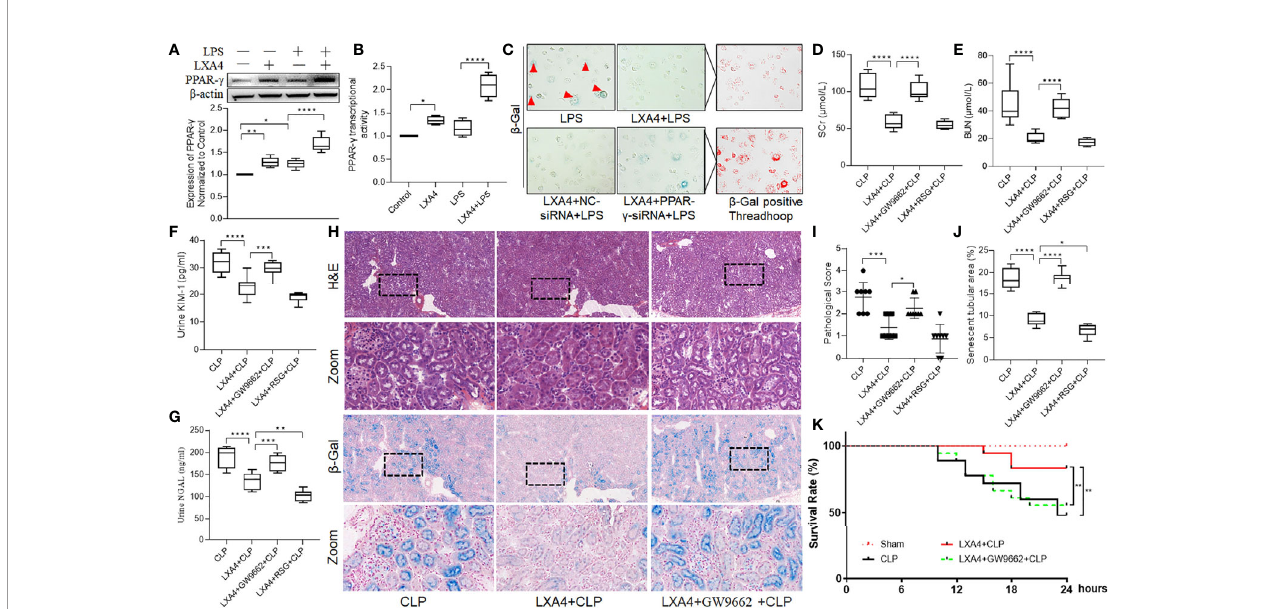
FIGURE 5 | LXA4 attenuates AKI and increased rat survival rate in a PPAR- g -dependent manner. NRK52E cells were treated with 1 m g/ml LPS for 24h with or without 10 nM LXA4 pretreatment for 12h, and PPAR- g -siRNA transfection for 48h. Male Sprague-Dawley rats were treated with or without LXA4 (100 µg/kg, i.p. ) for 30-min, or GW9662 (1 mg/kg, i.v. ) or RSG (10 mg/kg, i.v. ) for 20min prior CLP and were sacri fi ced at the time point of 18-h after surgery. Renal function alternation, renal pathological injury and senescence in the neighbored section were detected. (A) expression of PPAR- g among the four groups. (B) PPAR- g transcriptional activity among the four groups. (C) Representative images of NRK52E cell senescence among the four groups. (D – G) levels of SCr, BUN, urinary KIM-1 and NGAL among the four groups. (H) Representative images of renal damage and cellular senescence in the neighbored kidney section among the four groups (H&E and b -Gal staining; scale bar 100 m m). (I, J) Kidney histopathology scores and senescent tubular area among the four groups. (K) Survival rate after LXA4 treatment. The survival rate was observed for 24-h after the CLP operation, n=18. (A – G) Data are presented as mean ± SE (n = 8). * p < 0.05; ** p < 0.005; *** p < 0.001; **** p < 0.0001; LXA4, Lipoxin A4; RSG, Rosiglitazone; CLP, cecal ligation and puncture; H&E, hematoxylin – eosin staining; SCr, serum creatinine; BUN, blood urea nitrogen; KIM-1, kidney injury molecule-1; NGAL, neutrophil gelatinase-associated